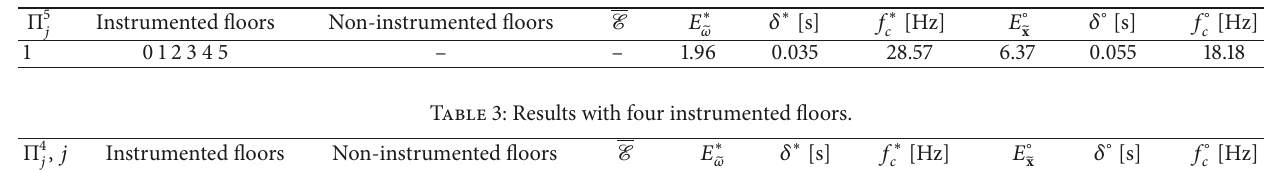
Table 2: Results obtained when all floors are instrumented.